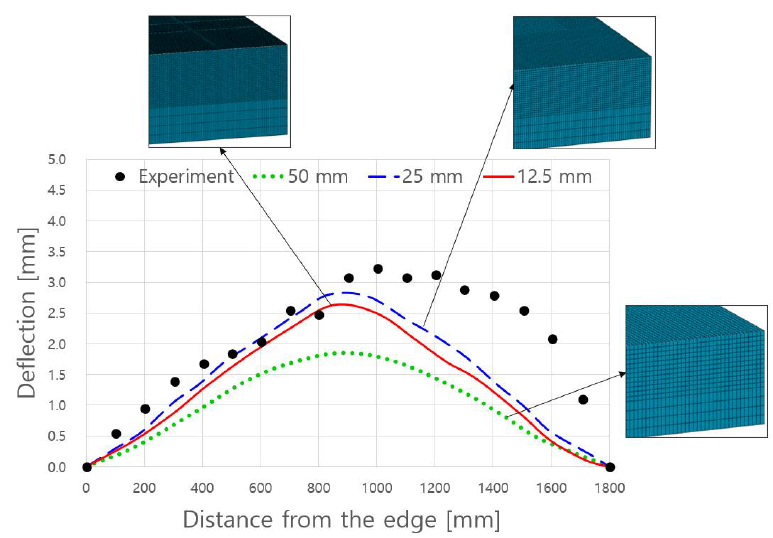
Figure 5. Mesh sensitivity study for water model.